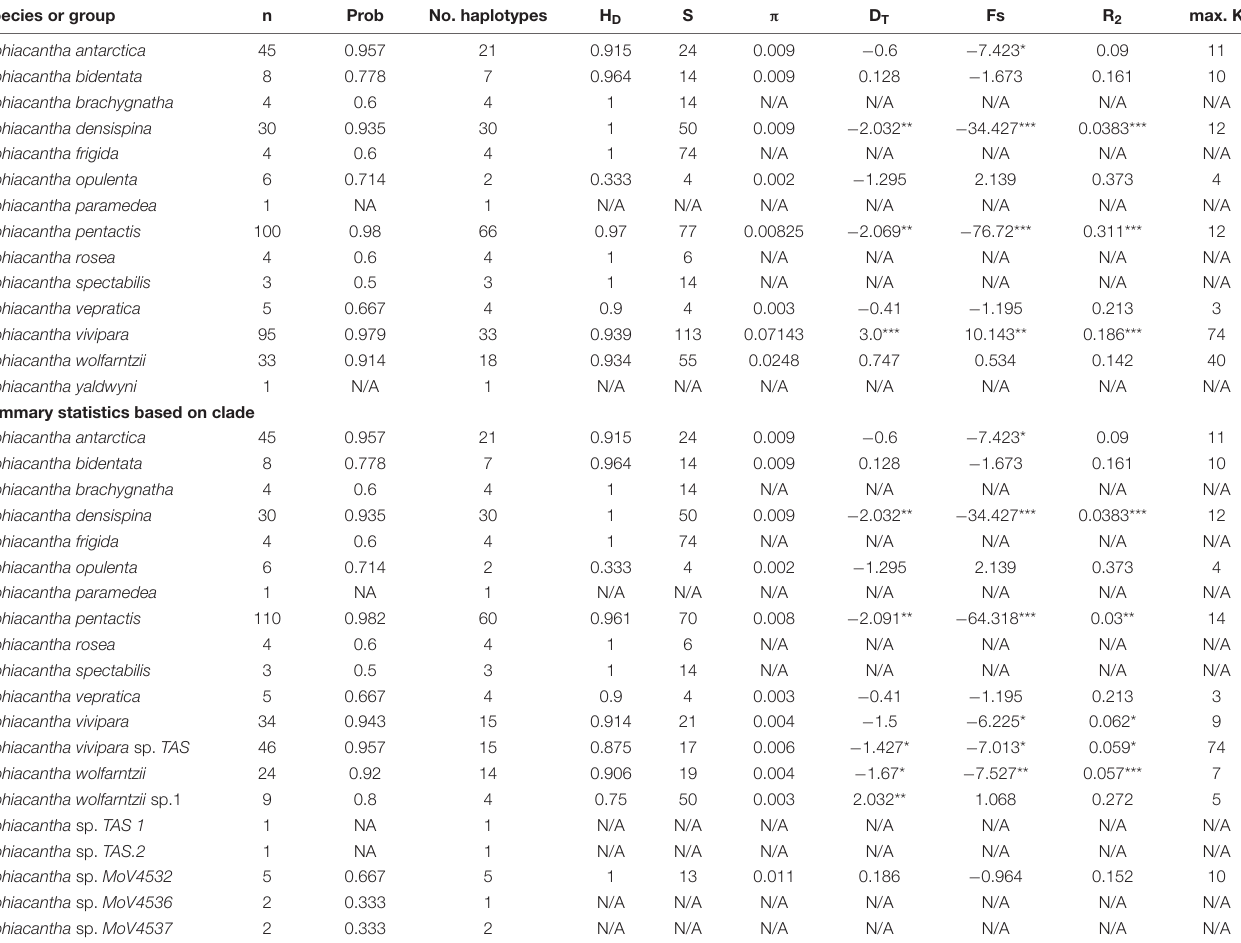
TABLE 1 | Summary statistics of CO1 sequences generated from morphologically grouped specimens and clade grouped specimens. Species or